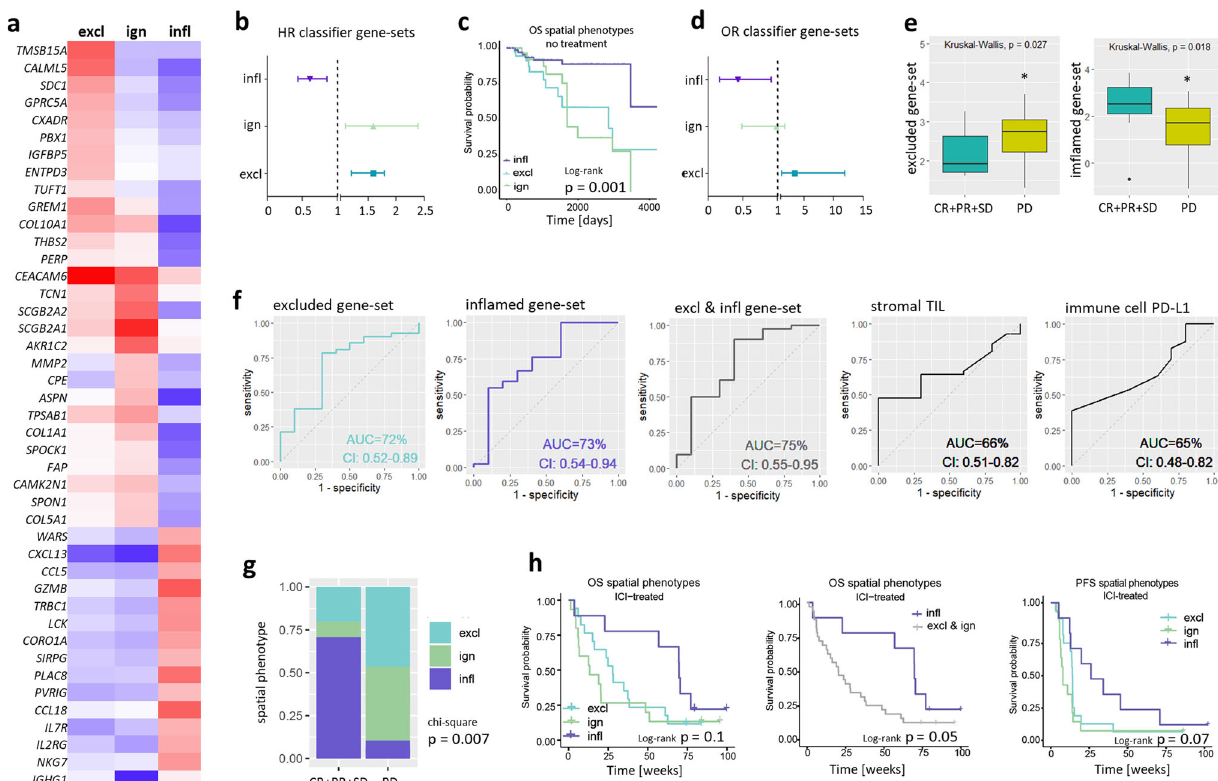
Fig. 2 Gene classi fi er assigns spatial phenotypes of CD8 + T cells and strati fi es metastasized TNBC patients according to ICI response. a Heatmap showing median expression of classi fi er genes per spatial phenotype in the discovery set (red: high expression, blue: low expression; Cohort A1, n = 101 TNBC). b Forestplots showing HRs and CIs (error bars) of classi fi er gene-sets (Cohort B, n = 196 basal-like BC). c Kaplan – Meier curves of assigned spatial phenotypes in primary TNBC patients (Cohort E, n = 137 TNBC, p-value shows two-sided log-rank test). d Forestplots showing Odds Ratios (OR) and CIs (error bars) for response to anti-PD-1 treatment of classi fi er gene-sets (Cohort D, TONIC trial, n = 53 metastatic TNBC). e Boxplots displaying the median with 25th – 75th percentile and range (outliers are displayed as dots) of the average expression of classi fi er gene-sets in responding (CR + PR + SD>24 weeks) and nonresponding (PD) patients (Cohort D, n = 53 metastatic TNBC, of which n = 10 CR + PR + PD, and n = 43 PD). f ROC curves predicting clinical response (PR + CR + SD) with areas under the curve (AUC) and CIs for gene sets of excluded-, in fl amed- or a combination of the two phenotypes (average expression of respective gene-sets was used) ( fi rst three panels), or for standardly used predictive markers, such as frequency of stromal TILs and PDL1 positivity of immune cells (Cohort D) (last two panels). g Proportions of assigned spatial phenotypes (excluded: cyan, ignored: green and in fl amed: purple) in patients with metastatic TNBC responding or not responding to anti-PD-1 treatment (pretreatment biopsies, n = 51) and h corresponding survival curves (Cohort D, p value shows two-sided log-rank test). Source data are provided within the source data fi le or can be retrieved under controlled access (see ref. 8 for details).